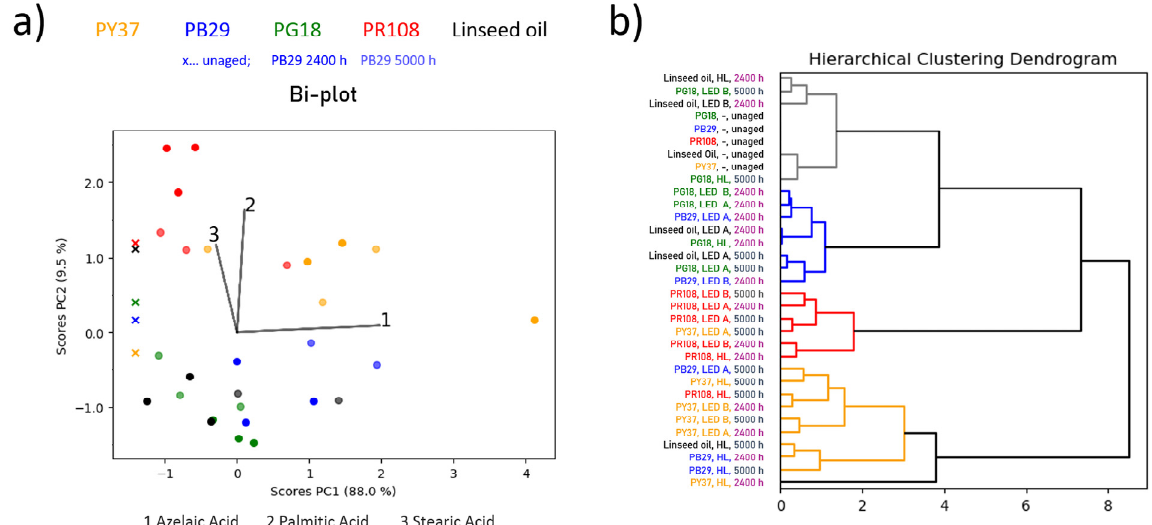
Figure 1. ( a ) Bi-plot (scores and loadings plot of PC1 vs. PC2) for linseed oil-based mock-ups. The colour of the scores corresponds to the pigment type (e.g., blue-coloured score = blue pigment; the binder without pigment is depicted in black) and its transparency to the ageing time when exposed to various illuminants (higher transparency indicated longer exposure times; unaged sample is indicated by a cross). ( b ) Dendrogram of the HCA of the PC1 and PC2 scores with the sample names highlighted according to the pigment type or ageing time, respectively.